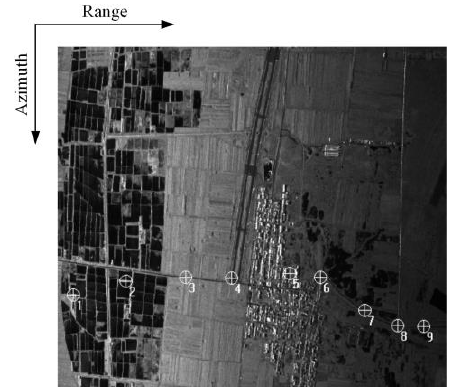
Figure 2. Amplitude image of the Pucheng area. The white crosses correspond to the CRs deployed over the test area. In the calibration result, the corrected values for all the five variables converge through eight iterations. In the Figure 3, we can see the most of corrected values tend to be stable after three iterations. For the variables